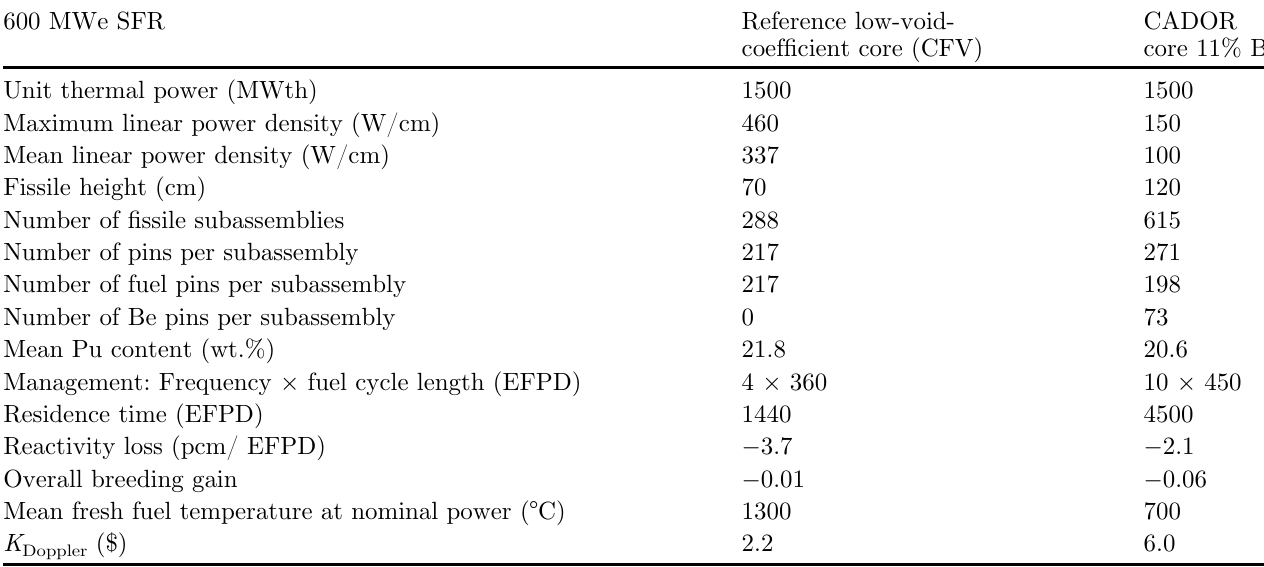
Table 1. Comparison between the CADOR and CFV cores.